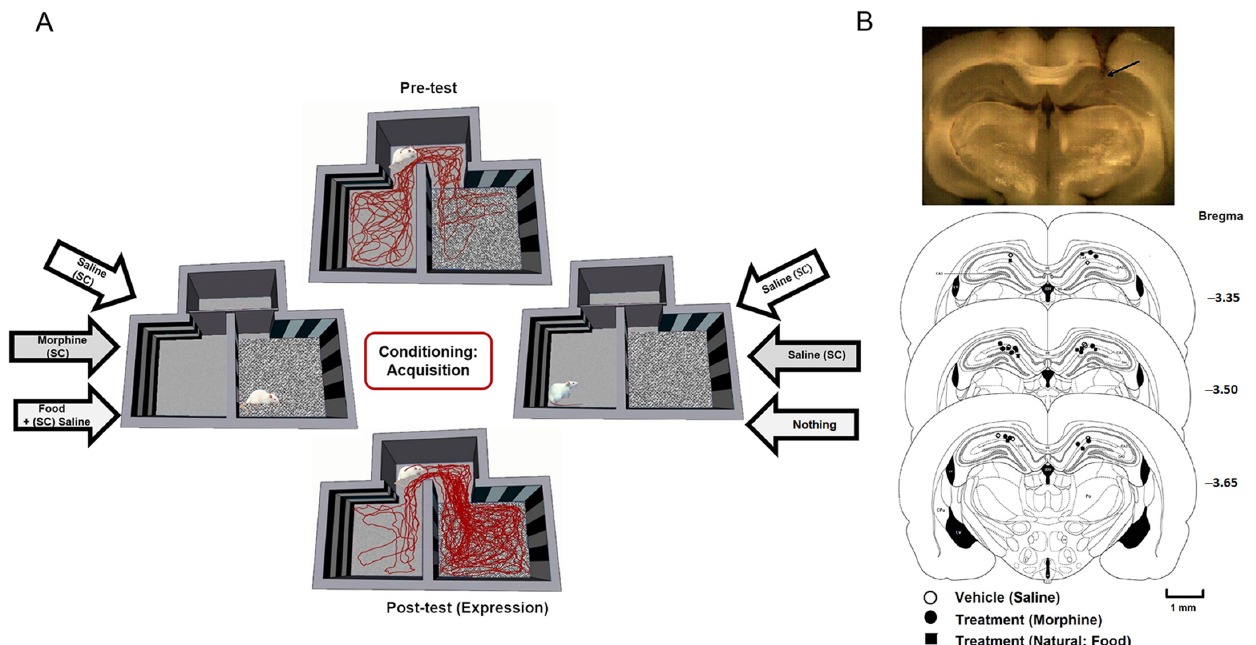
Figure 1. ( A ) Experimental protocols of saline, morphine ‐ CPP, and food ‐ CPP, including the pre ‐ test, acquisition, and post ‐ test. Animal track is marked by red line. ( B ) A coronal photomicrograph of electrode trace showing the CA1 in the rat. Arrow shows the tip of electrode. Three schematic diagrams of the rat brain’s coronal sections, indicating the approximate locations of the electrode sites ( ○ saline group; ● morphine group; ■ food group). Electrodes were implanted ipsilateral into the right or left side of the CA1 region.